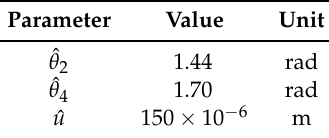
Table 1. Constants.